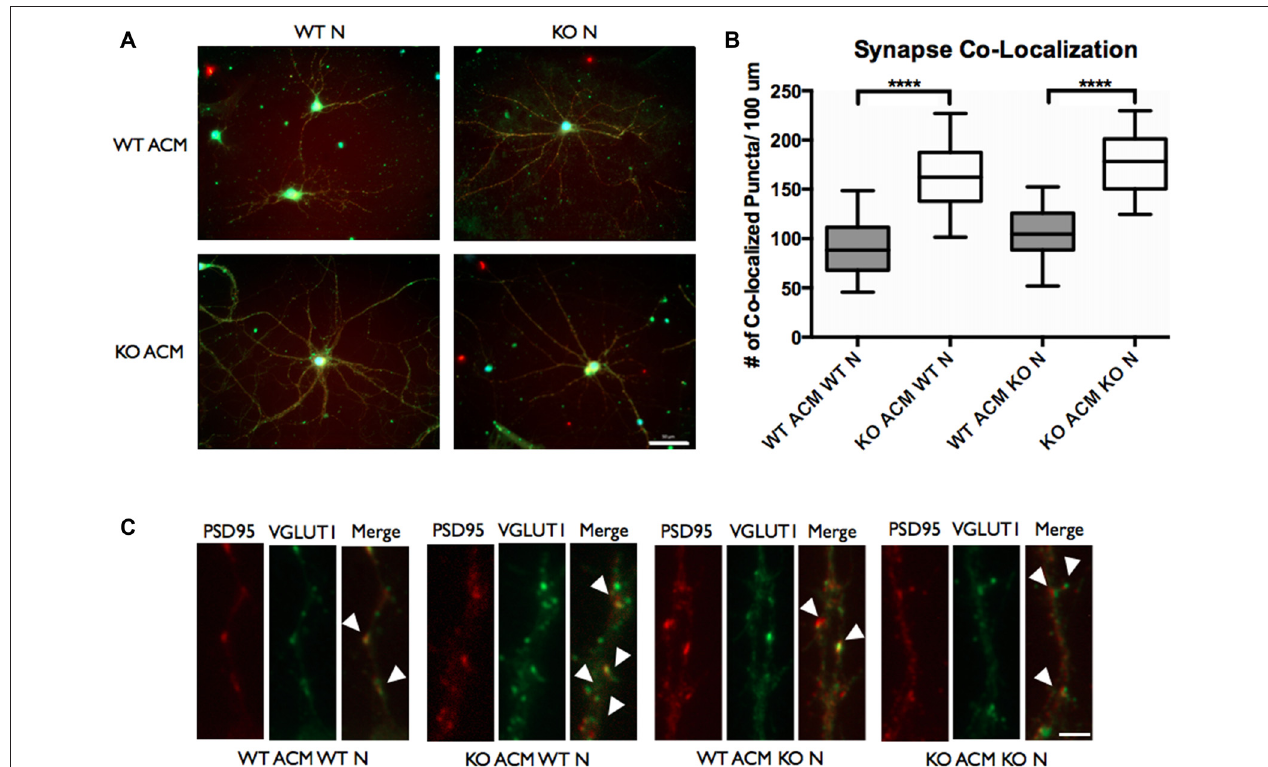
FIGURE 8 | The number of vesicular glutamate transporter 1 (VGLUT1)/post synaptic density protein 95 (PSD95) co-localized puncta of WT and FMR1 KO neurons was increased when plated with ACM from FMR1 KO astrocytes, compared to those plated with media from WT astrocytes. (A) WT and FMR1 KO neurons with ACM from WT and FMR1 KO astrocytes maintained for 12 days in vitro , co-labeled with antibodies against VGLUT1 and PSD95. Scale bars = 50 µ m. (B) Measures of intracortical synapse number (identified by the co-localization of VGLUT1 and PSD95 puncta) obtained from cultures containing WT or FMR1 KO neurons, supplemented with ACM from WT or FMR1 KO astrocytes ( n = 4; 40 neurons /condition). Statistical differences denoted with four asterisks, P < 0.0001. (C) WT and FMR1 KO neurons supplemented with ACM from WT or FMR1 KO astrocytes and maintained for 12 days in vitro . White arrows indicate co-localized PSD95 (red) and VGLUT1 (green) puncta. Images were obtained using a 40 × objective with a Zeiss Axioimager M2. Scale bars = 10 µ